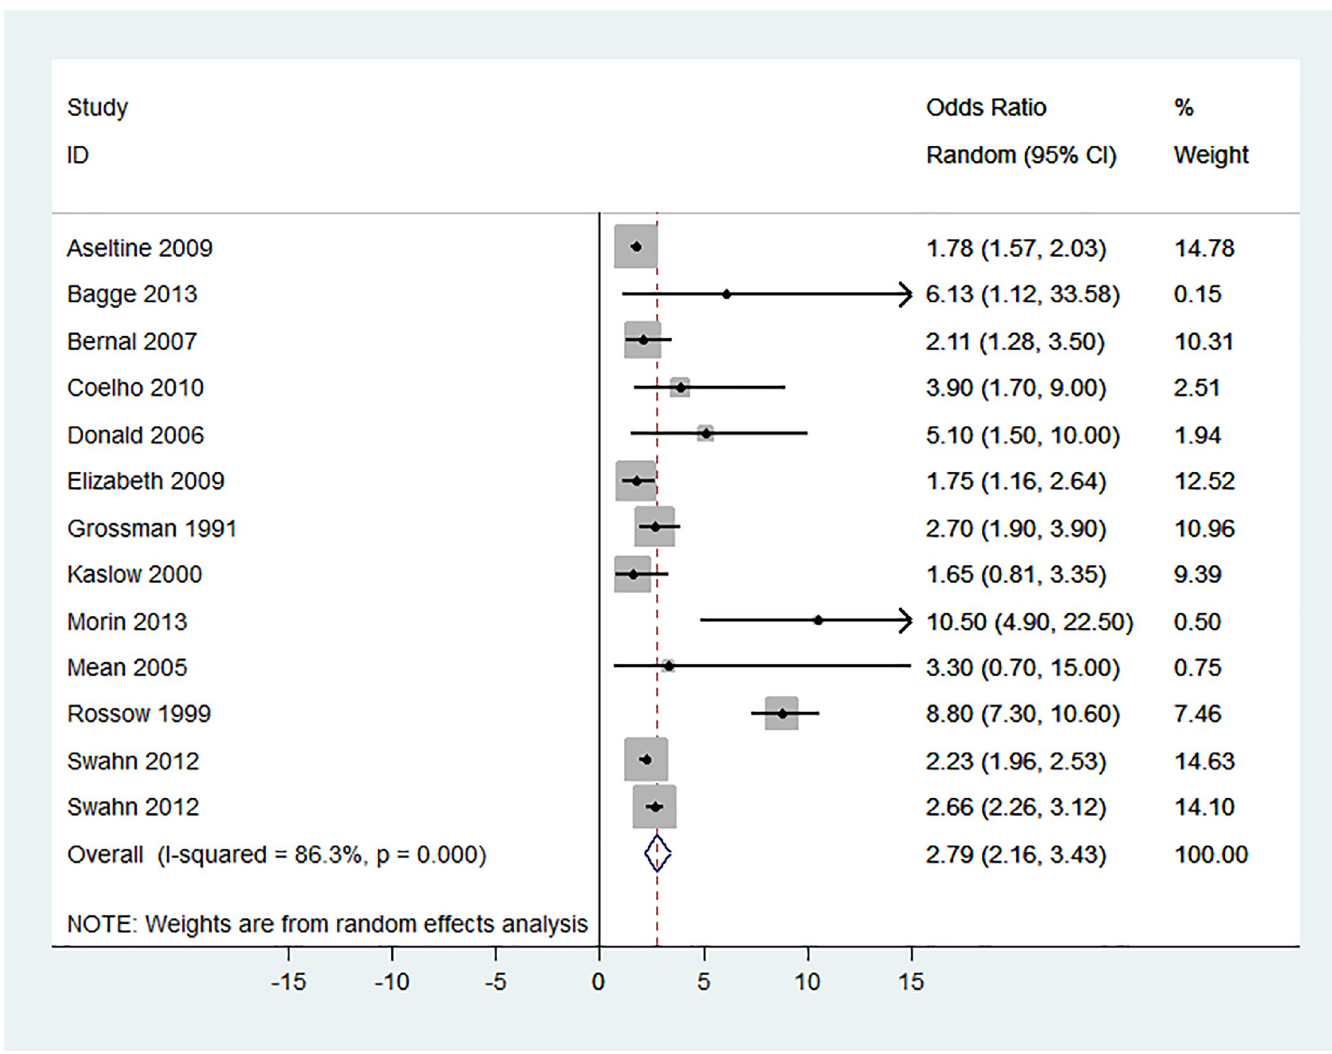
Fig 3. Forest plot of the association between alcohol use disorder and suicide